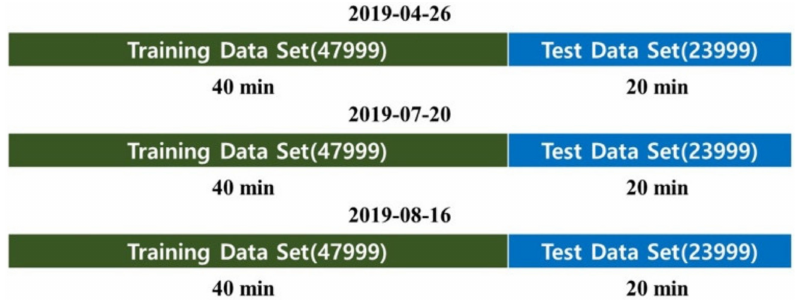
Figure 11. Summary of training datasets and test datasets.